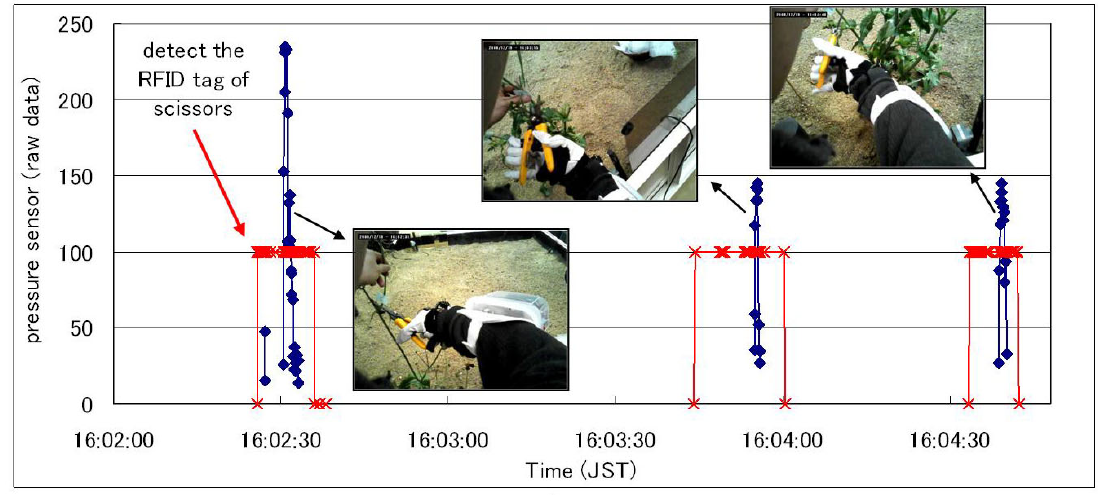
Figure 8. Recognition result of cutoff